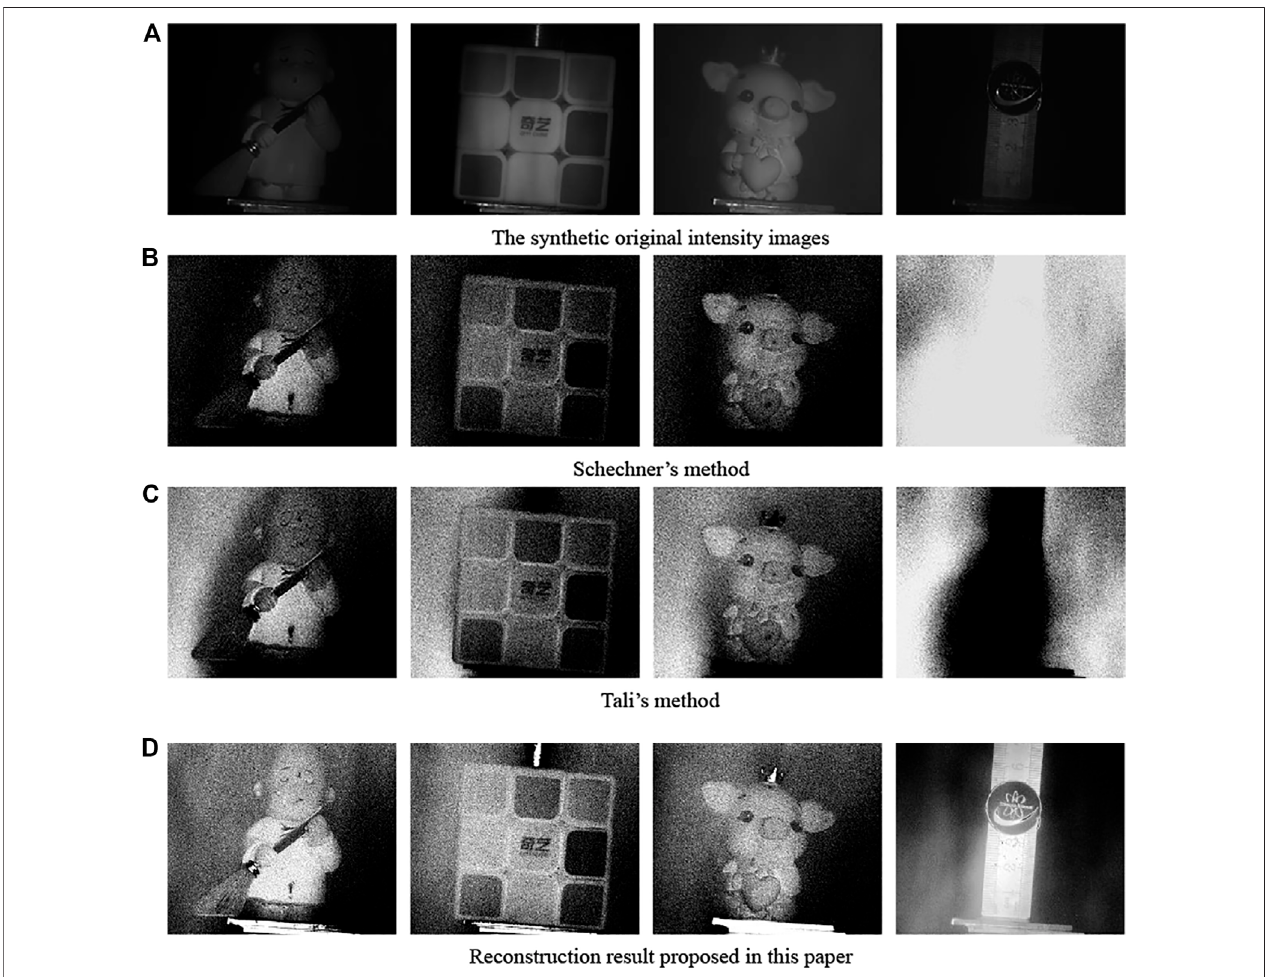
FIGURE15| Theprocessingresultsofothermaterialtargetundertheconditionofbubbleconcentrationisbubble3andmediumconcentrationisdensity1. (A) The synthetic original intensity images. (B) Schechner ’ s method. (C) Tali ’ s method. (D) Reconstruction result proposed in this paper.